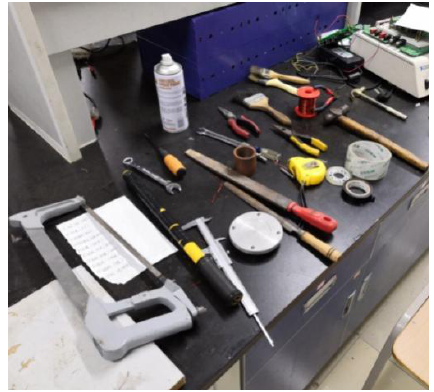
Figure 6. Assembly tools.